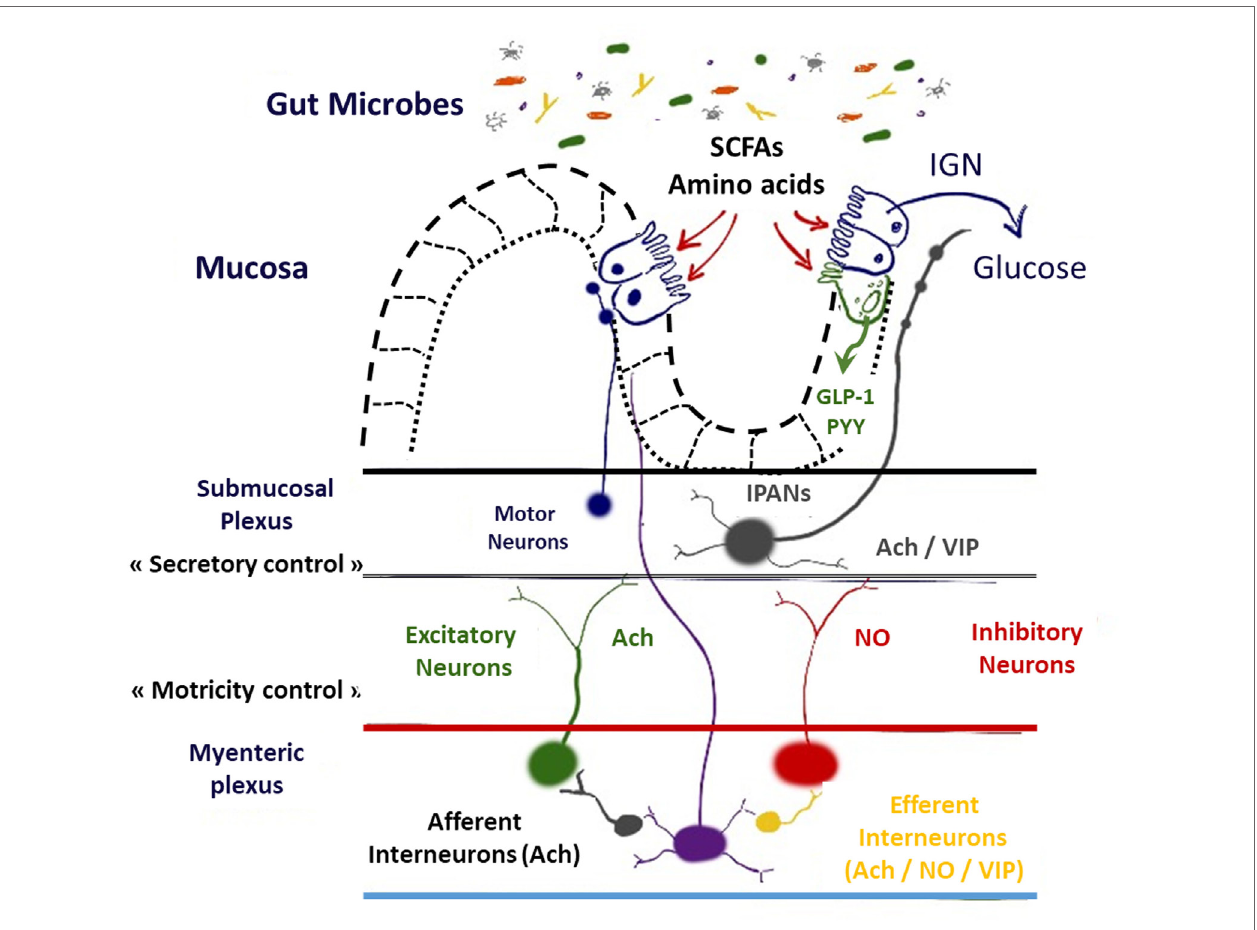
FiGURe 1 | Schematic representation of interrelations between hormones, nutrients, neurotransmitters, and enteric nervous system. Abbreviations: SCFA, short chain fatty acids; GLP-1, glucagon-like peptide-1; PYY, peptide YY; IPAN, intrinsic primary afferent neurons; Ach, acetylcholine; NO, nitric oxide; VIP, vasoactive intestinal peptide; IGN, intestinal gluconeogenesis.